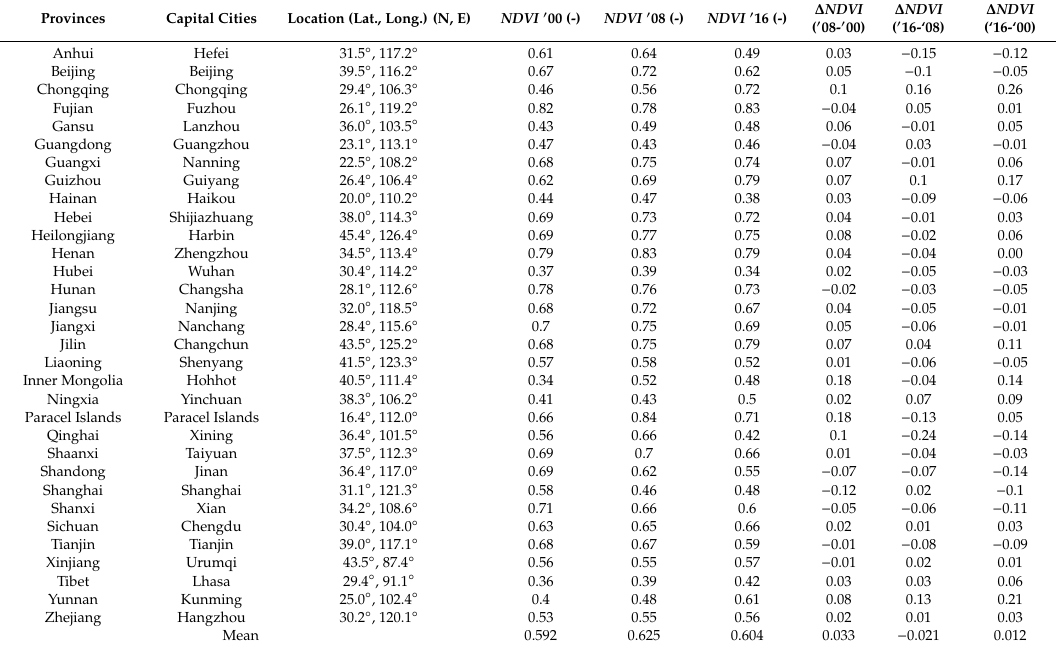
Table 2. NDVI of all provincial capitals and its variation from 2000 to 2016. Provinces